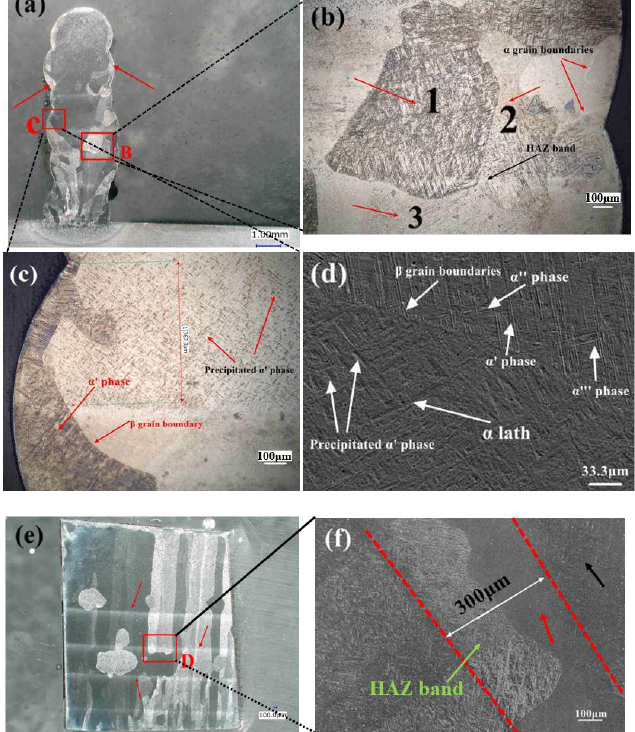
Figure 6. ( a ) An optical microscopy image of the cross-section cut from the X-Z plane. Red arrows indicate β grains at the edge area. ( b ) The area indicated in panel B of image ( a ). ( c ) The area indicated in panel C of image ( a ). ( d ) The microstructure of α’ and the precipitated α’ phase, as shown by the SEM. ( e ) The cross-section was cut from the second layer to the seventh layer of the Y-Z plane. ( f ) The area indicated in panel D in image ( e ) is revealed by the SEM. The red arrow indicates a transition area. The black arrow indicates the precipitated α’ phase. The microstructure of a seven-layer thin-wall sample is shown in Figure 6a,e in different cutting orientations, i.e., the X – Z and Y – Z planes. Compared to the microstructure of the single-bead sample in Figure 4a, the microstructure of the thin-wall part exhibited worse oxidation, which can be observed in the edge area of each layer. The number and size of the pores of the thin wall part were decreased, compared to the single- bead sample. This may be a result of the upper layers ’ re-heating. Due to the sequential thermal cycling, the pores of the lower layers became smaller and even disappeared. Figure 6a,b shows the β grains with different colors, and the β grains marked with the numbers 1, 2, and 3 in Figure 6b displayed different depths of martensitic surface relief, macroscopically expressed as different etching reactions. The grain numbered 1 in the figure had the deepest color, which may be attributable to the different heat gradients. In the laser printing conducted in this study, the heat source that was combined with two irradiated lasers must have several heat gradients, which resulted in a complex heat